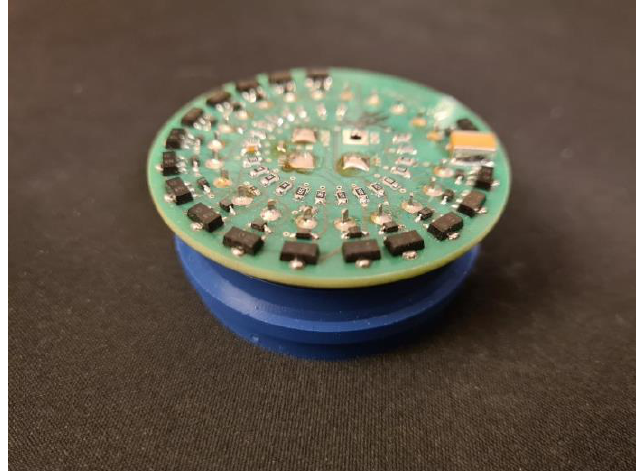
Fig. 3 Implementation of a linearized active divider for high pulse frequencies